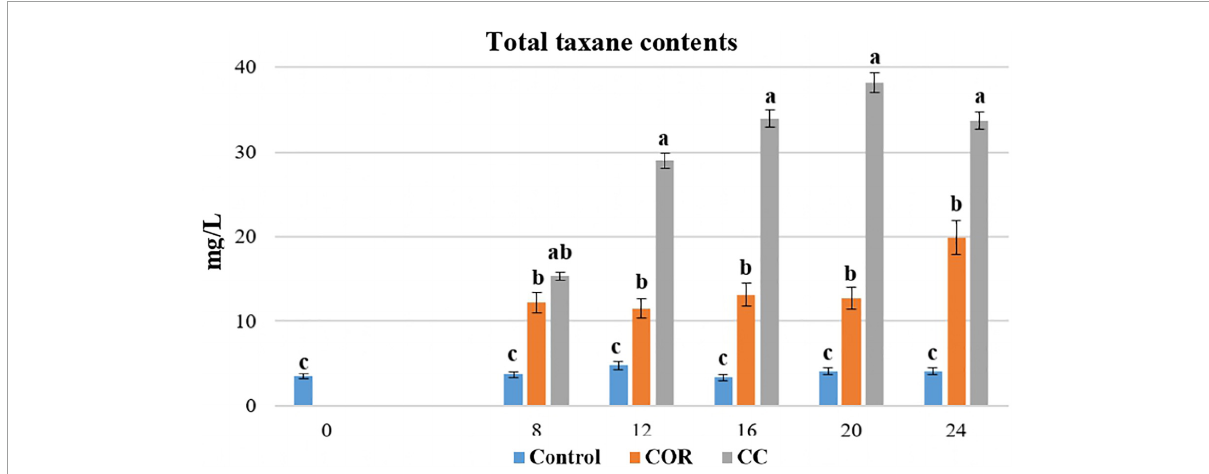
FIGURE3 Total taxanes produced in T. baccata cell cultures throughout 24 days of culture in control conditions, with the addition of coronatine (COR) or supplemented with COR + β -methyl-cyclodextrins (CC). Values presented are means ± SD ( n = 3). Values followed by different letters are significantly different ( P ≤ 0.05) according to Tukey’s honestly significant difference